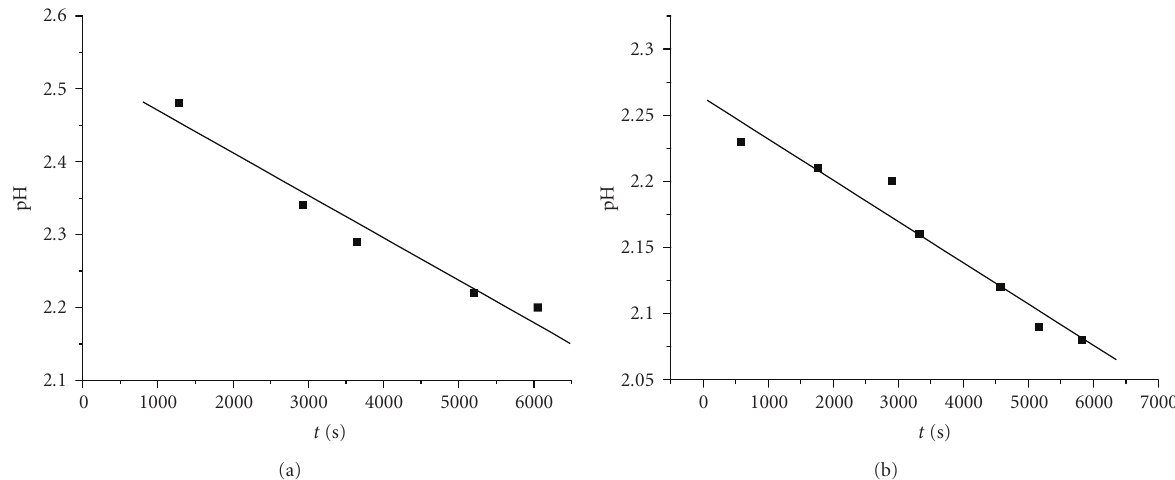
Figure 3: The pH versus time plots of typical mixtures of DHBA/Cr(III). Conditions: (a) [2,4-DHBA] 0 = 4,87 · 10 − 2 M, [Cr(III)] 0 = 2,50 10 − 3 M, T = 298 K; (b) [2,5-DHBA] 0 = 4,87 · 10 − 2 M, [Cr(III)] 0 = 2,50 · 10 − 3 M, T = 298K.